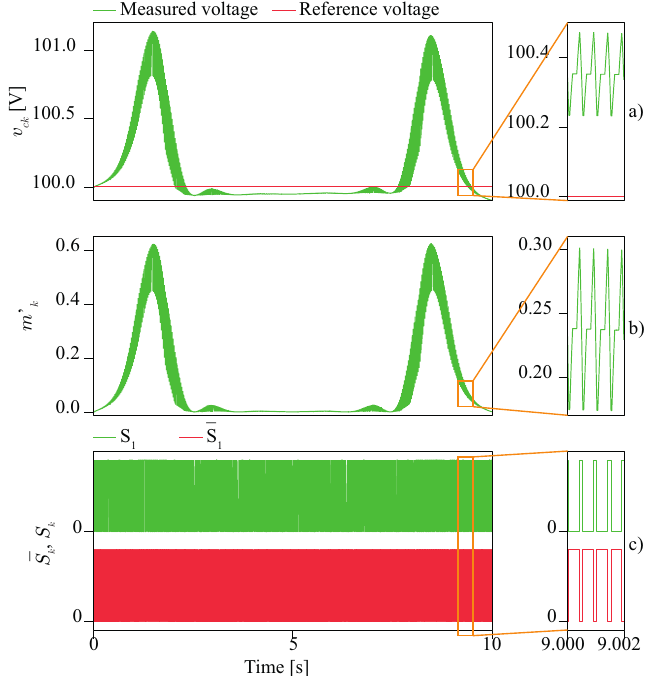
Figure 9. ( a ) Measured voltage and reference voltage signals v ck . ( b ) Modulation index n k . ( c ) Switching signals S k .